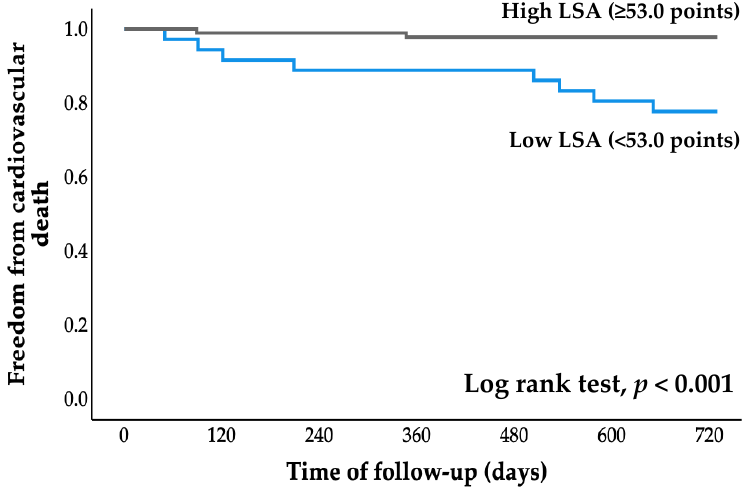
Figure 3. Kaplan – Meier curve for cardiovascular death. LSA, life-space assessment. Figure 3. Kaplan–Meier curve for cardiovascular death. LSA, life-space assessment. Table 3. Cox proportional hazards analysis (cardiovascular